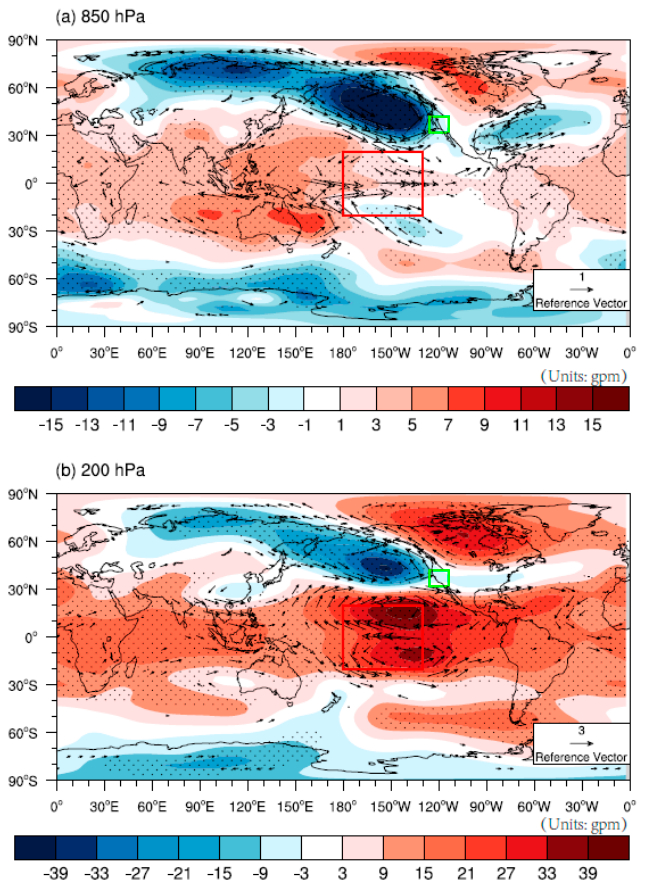
Figure 4. Geopotential height (shading; gpm) and horizontal velocity (vector; m/s) at 850 hPa ( a ) and 200 hPa ( b ) in winter regressed to the box-averaged SST (red box). The green box represents the selected California area. Only wind exceeding the 90% confidence level is shown. Areas with dots exceed the 90% confidence level.